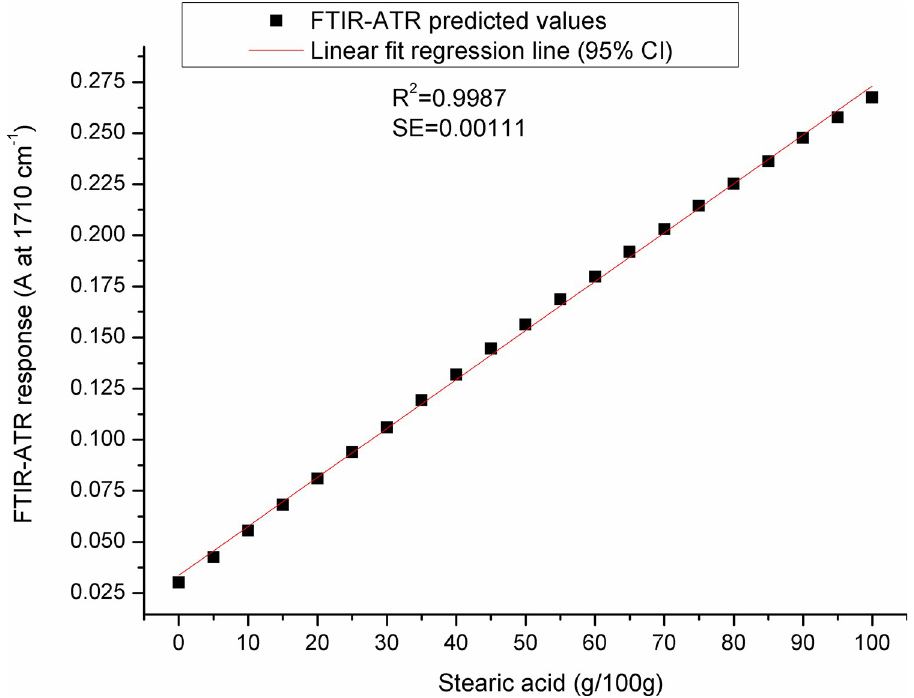
Fig 9. Prediction performance parameters of the calibration curve constructed for determination of the stearic acid share in beeswax: A scatter plot of FTIR-ATR predicted values (instrument response) versus real (known) stearic acid share values using the spectral region with an absorption maximum at 1710 cm -1 .